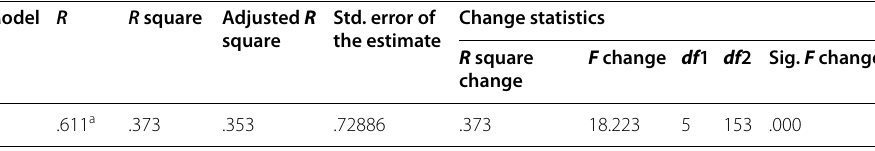
Table 5 Model summary. Source: own survey (2020)